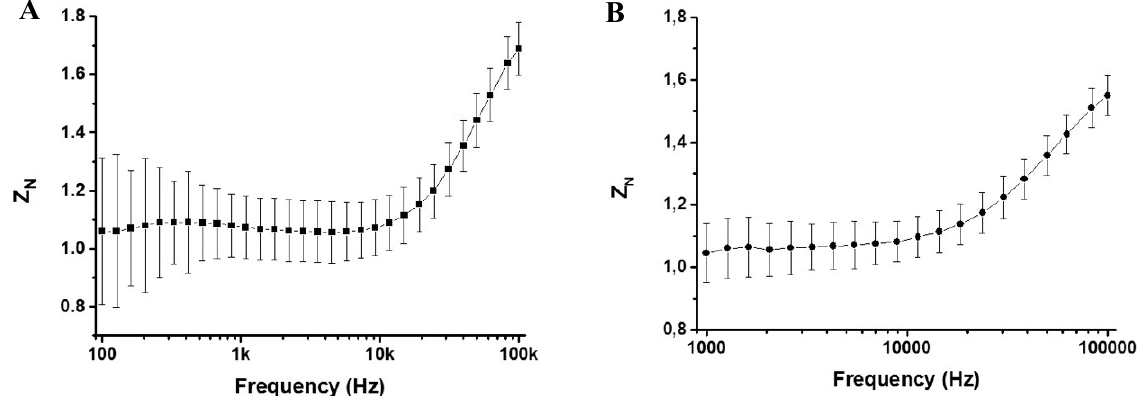
Figure S1. Normalized impedance vs. frequency for A ) LUHMES (60,000 cells/cm 2 ) and B ) hVM1 Bcl-X (120,000 cells/cm 2 ). The spectra were acquired 48 h after cell seeding. (Error bars: standard deviation, n = 3) The result indicates that the highest value was obtained for 100 kHz. Impedance at 100 kHz was then used to calculate the Cell Index in the subsequent